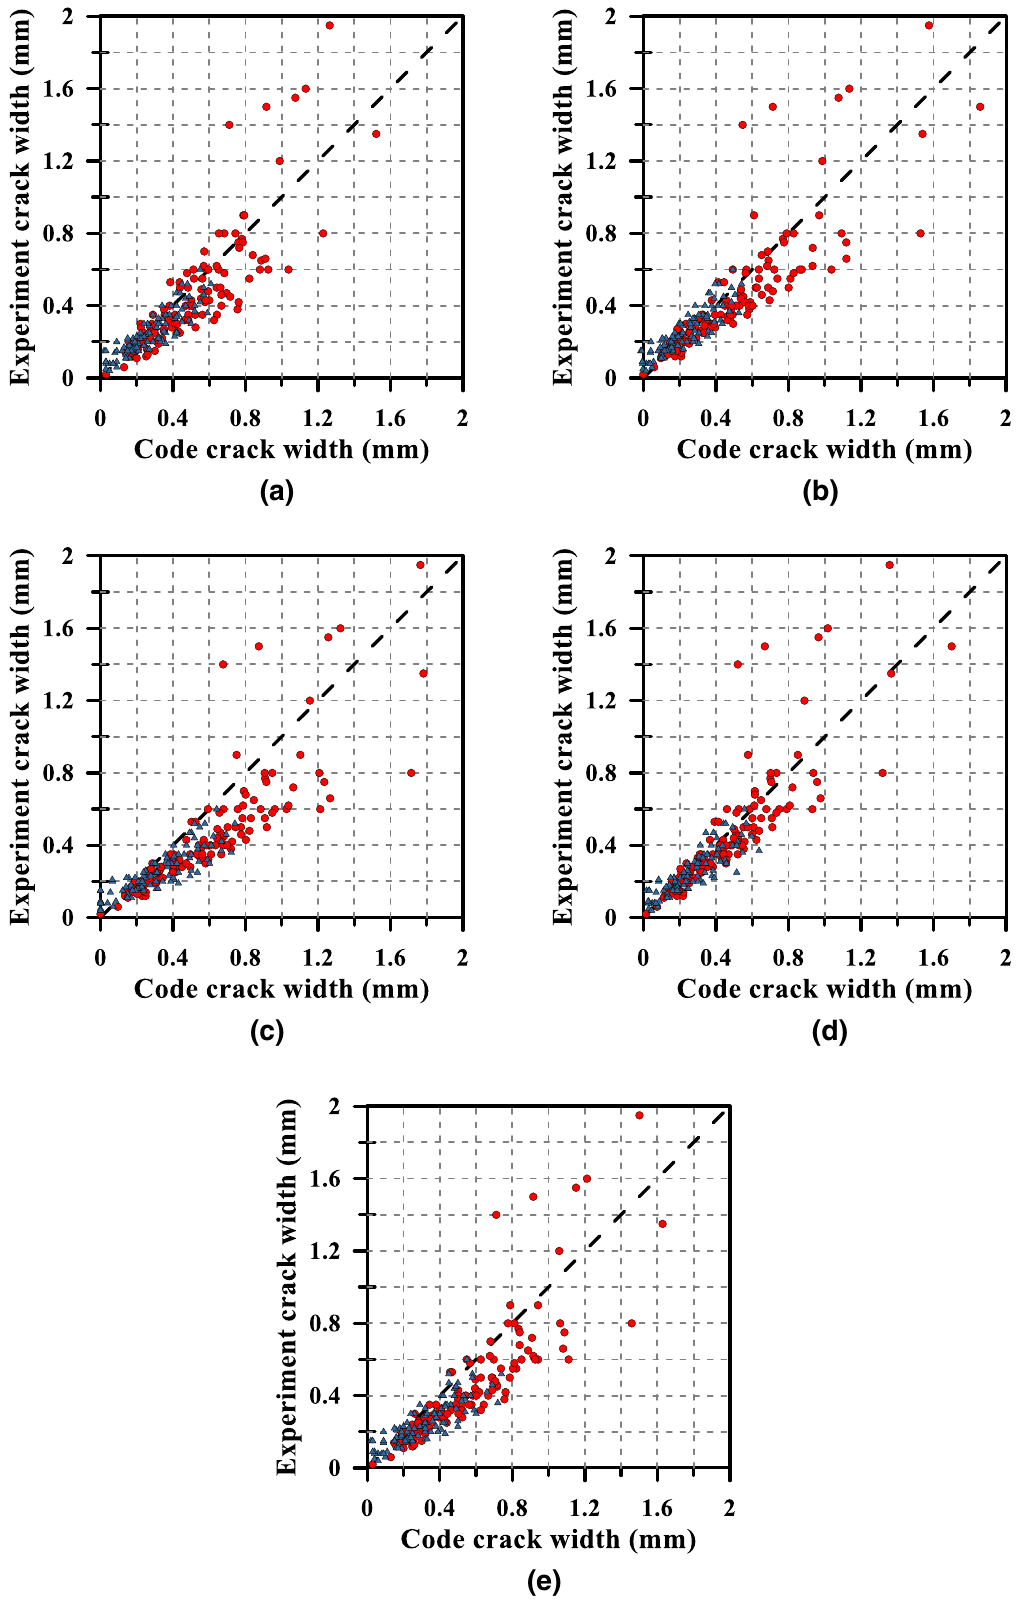
Fig. 17 Comparison of the measured and calculated maximum flexural crack widths. a ACI 318 (2014), b CEB-fib Model (2010), c AIJ (2010), d JSCE (2007), and e ACI 318 (2014) (Modified) (Circle points are the specimens in this work; triangle points are the specimens in the references (Chiu et al. 2014,